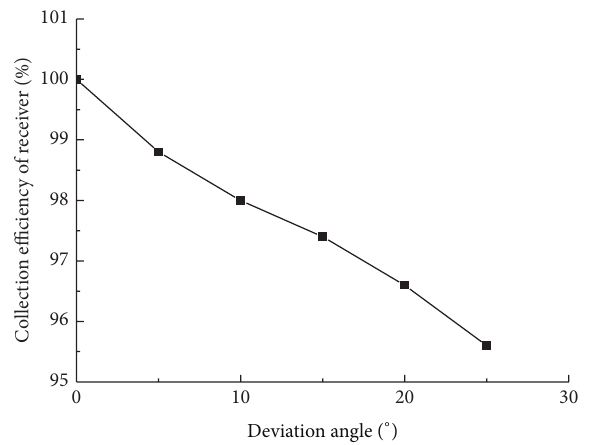
Figure 6: The influences of the angle between receiver plate and concentrator symmetry axis on the concentrator